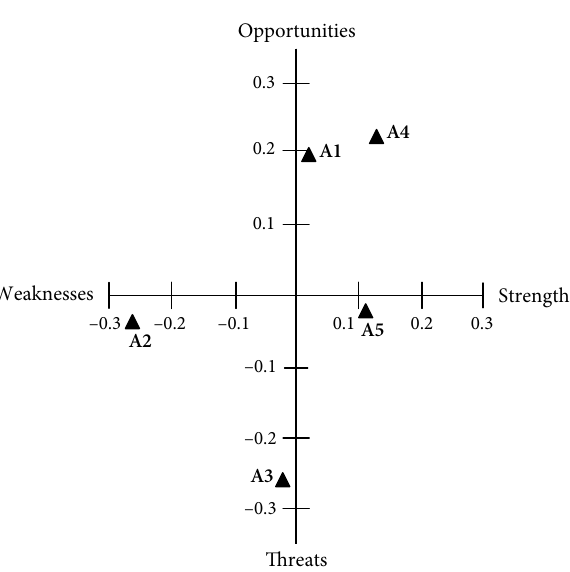
Fig. 4. The matrix of the 2 nd -tier city in China under SWOT